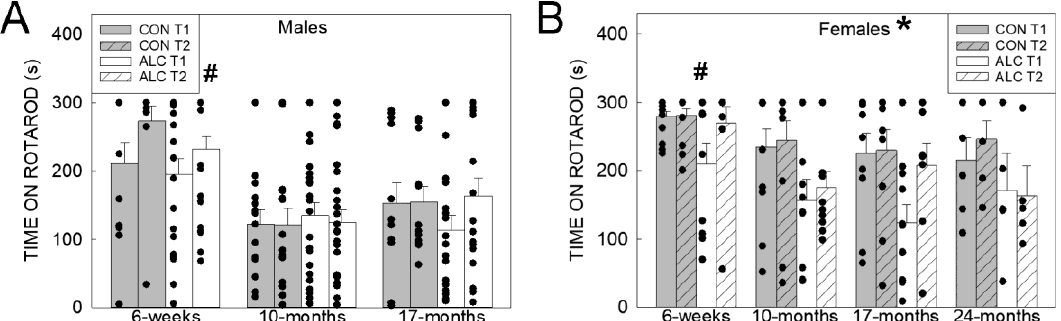
Figure 3. ALC and CON performance on accelerating rotarod. ( A ) Six-week-old males performed better than at older ages. No other differences were found. ( B ) ALC females perform worse than age-matched CON females, and 6-week-old females performed better than at older ages. Values are mean ± SEM, dots represent values for individual animals. The number of animals tested in each group is presented in Supplemental Table S1. T1, training trial; T2, test trial. * Indicates ALC differs from CON at p ≤ 0.05. # Indicates difference between 6 weeks vs. older ages, p <